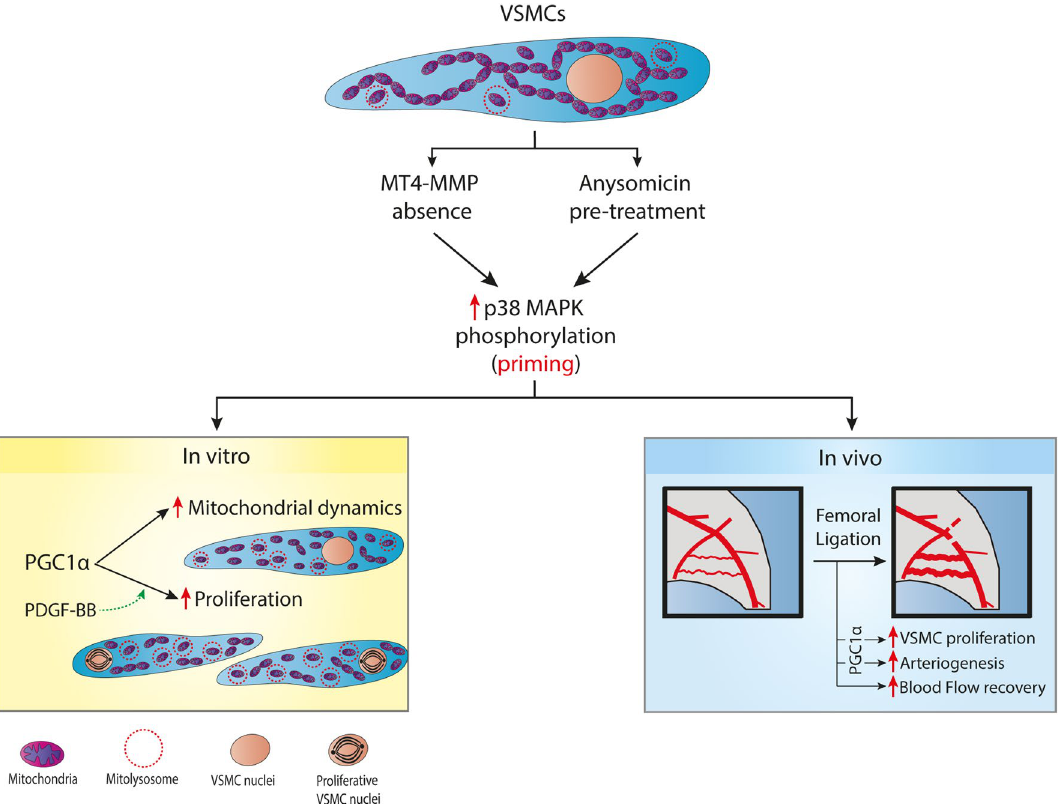
Figure 6. Graphical abstract: An increase in p38 MAPK phosphorylation in VSMCs (caused by external preconditioning with anisomycin or by knockdown of MT4-MMP) leads to a basal primed state in which mitochondrial dynamics is enhanced via PGC1α. This cellular context allows for a better proliferative response of VSMCs to in vitro treatment with PDGF-BB. Furthermore, in vivo, after femoral artery ligation, such VSMC priming allows for better (PGC1α-dependent) VSMC proliferation and arteriogenesis, and thus more efficient recovery of blood maintained during the whole treatment. For mitochondria division inhibition, mdivi-1 (M0199, Sigma-Aldrich) diluted in DMSO was added at 10 µM 1 h before PDGF-BB treatment, and was maintained during the whole treatment. For p38 activation, anisomycin diluted in DMSO was added at 150 ng/ml 2 h before PDGF-BB treat- ment, and was removed when adding PDGF-BB. VSMC immunofluorescence, image acquisition and analysis. Cells were fixed in 4% PFA for 10 min RT and washed twice in PBS. Next, cells were permeabilized for 15 min at RT with 0.2% Triton X-100 in PBS, followed by a 1 h RT blocking in 5% goat serum and 5% BSA in PBS. Then primary antibodies (Supplementary Table S2) were incubated O/N at 4 °C in 2.5% goat serum and 2.5% BSA in PBS. The next day, sections were washed at RT for 10 min 3 times in PBS and secondary antibodies (Supplementary Table S2) and DAPI (1/5000) for nuclear staining were incubated for 1 h at RT in 2.5% goat serum and 2.5% BSA in PBS. Finally, cells were washed 4 times 10 min. For proliferation, cells were imaged with confocal Nikon A1R, acquiring a complete 5-z-stack tile scan of the ibidi well every 1 µm using a 10 × objective. Fiji/Image J Software was used to obtain the total number of cells by quantifying the number of DAPI + nuclei. DAPI + /SMA + were considered as VSMCs and DAPI + /SMA + /Ki67 + as proliferative VSMCs. The percentage of VSMCs was calculated as the number of VSMCs (SMA + ) relative to the total number of cells (DAPI + ), and the percentage of proliferative VSMC was calculated as the Ki67 + /SMA + number (proliferative VSMC) versus the number of VSMC (SMA + ). For mitochondrial analy- sis, cells were fixed for 30 min with 4% PFA at RT and permeabilized using 0.1% SDS in PBS for 30 min at RT. Then, cells were incubated with primary antibodies (Supplementary Table S2) diluted in 3 mg/mL BSA, 100 mM Glycine, 025% Triton X-100 in PBS for 1 h at RT. Cells were then incubated with corresponding secondary anti- bodies (Supplementary Table S2) diluted in the same buffer for 1 h at RT and counterstained with DAPI. Three washes with PBS were performed after every step. Cells were imaged using a 63 × oil immersion objective in a TCS SP5 Confocal System (Leica). At least three images per sample were acquired. For co-localization analysis, z-stacks (z-step: 0.5 µm) were processed using JaCoP 82 with a standard manually-adjusted threshold for the red (C1-LAMP1) and green (C2-TOMM20) channels. Mitochondrial and lysosomal mass values were obtained by quantifying the TOMM20- or LAMP1-positive area per cell, respectively, using Fiji/ImageJ. For mitochondrial net study nine cells per well and condition were analyzed with the Mitochondrial Analyser plug-in 26 .